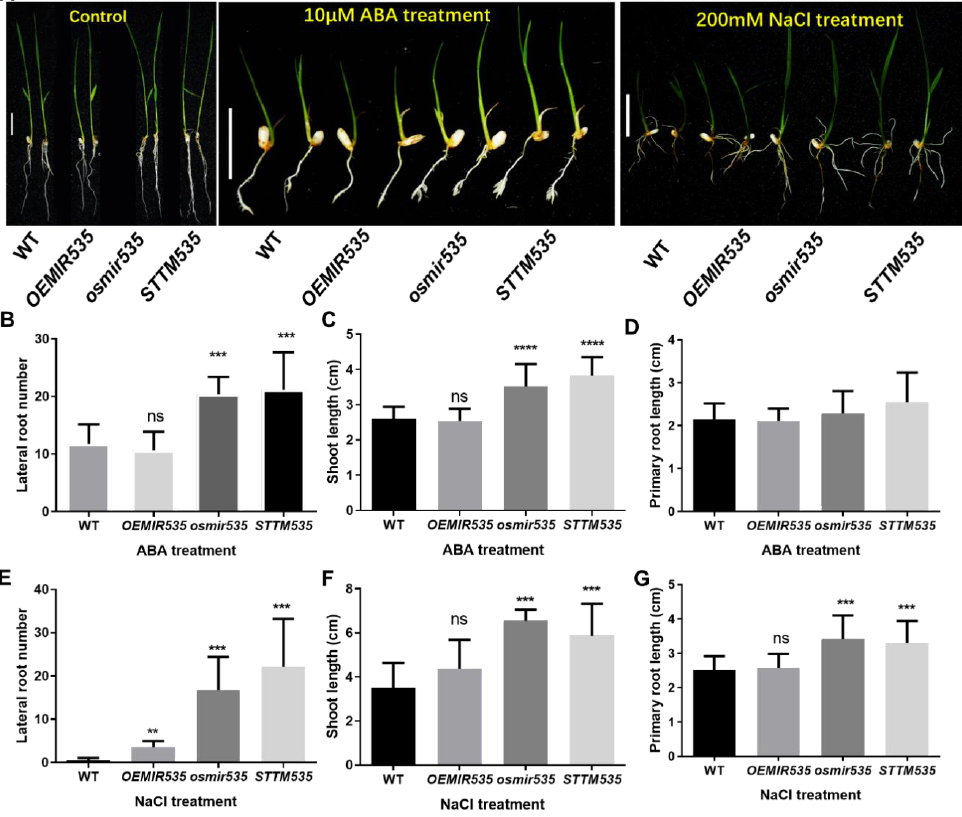
Figure 3. External ABA and NaCl stress testing of OsmiR535 overexpression, STTM inhibition and CRISPR / Cas9 knockout seedlings. ( A ) 10 µ M ABA and 200 mM NaCl treatment of WT and transgenic lines. Lateral root number ( B ), shoot length ( C ), and primary root length ( D ) of WT and transgenic lines under 10 µ M ABA treatment. Lateral root number ( E ), shoot length ( F ) and primary root length ( G ) of WT and transgenic lines under 200 mM NaCl treatment. Three replicates of 15 plants were treated. Error bars represent the SD. “ns” represents no significance; One asterisk (*), double asterisk (**), triple asterisk (***) or quadruple asterisk (****) represents p < 0.05, p < 0.01, p < 0.001 or p < 0.0001 or statistical difference from the controls, respectively.